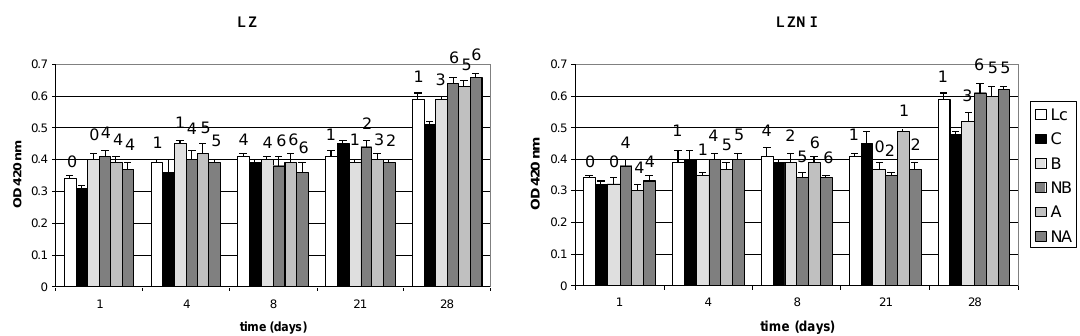
Figure 2. Values of free amino groups, expressed as OD at 420nm and determined by the trinitrobenzenesulphonic acid (TNBS) method, and halo diameter (mm) formed by the nisin produced in the cultures in lawns of L. plantarum LZ. Lc, pure culture of L. lactis subsp. lactis DSM 20729; C, pure culture of L. plantarum LZ or LZNI; B, combination L. plantarum /nisin producer 102:102 CFU mL −1 ; NB, combination B with 10 IU/mL of nisin added; A, combination L. plantarum /nisin producer 102:104 CFU mL −1 ; NA, combinations A with 10 IU/mL of nisin added. Numerals above histograms represent the average diameter of the inhibition haloes formed by 10 μL aliquots of the co-cultures.